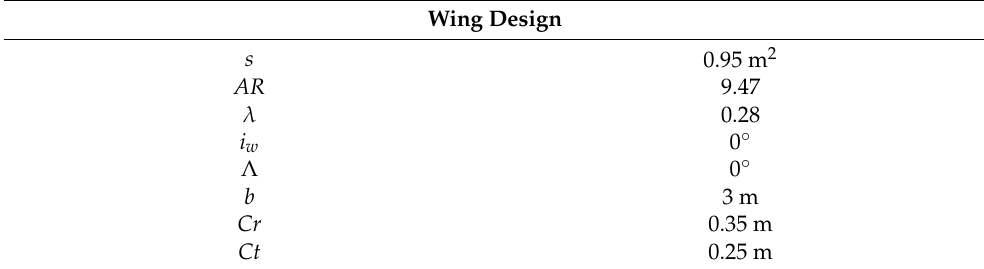
Table 4. Wing design calculation.